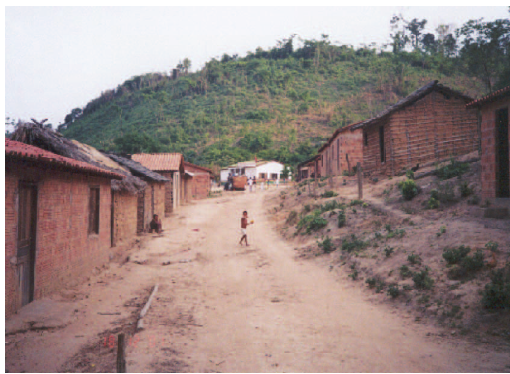
Figure 2 - Typical image of rural Buriticupu. Figura 2 - Imagem típica encontrada nas áreas